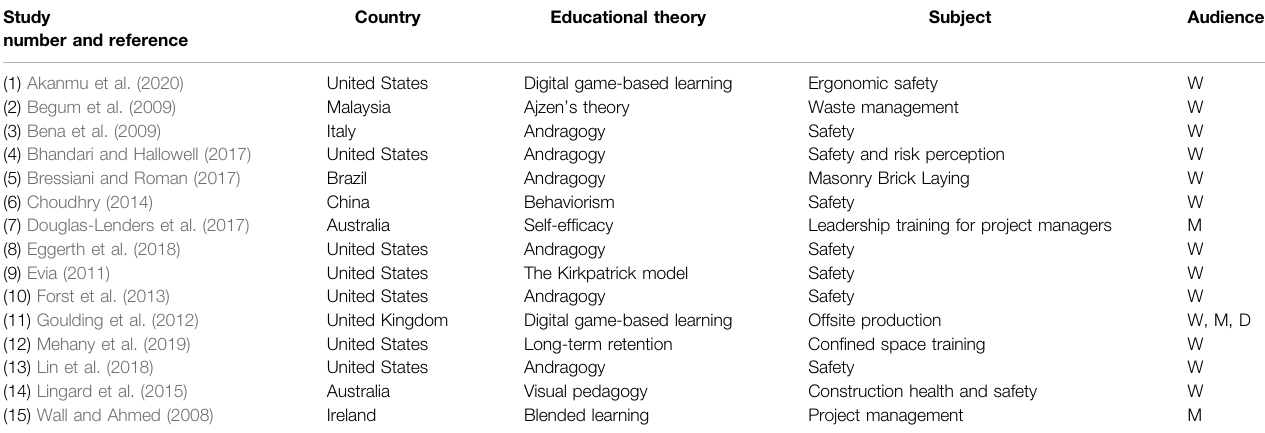
TABLE 2 | Identi fi ed educational theory-integrated construction industry training studies. Study number and